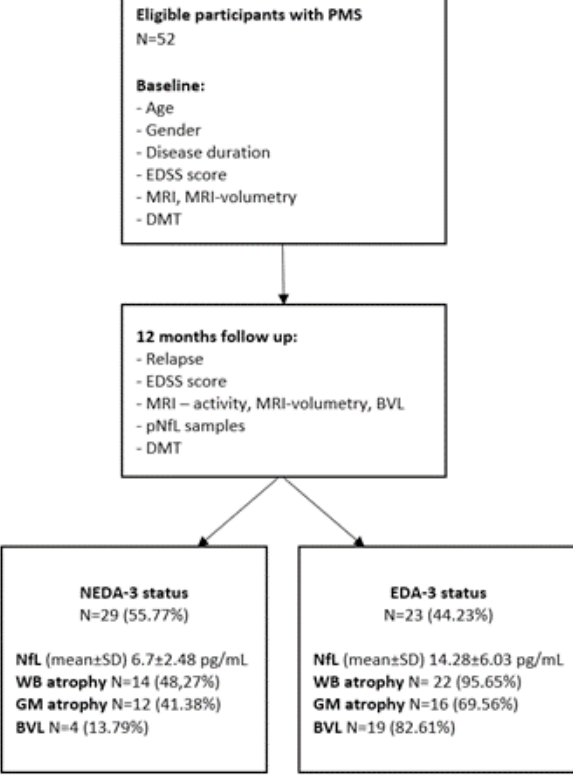
Fig. 1. A schematic flowchart diagram showing the procedure by which data were tested in MS